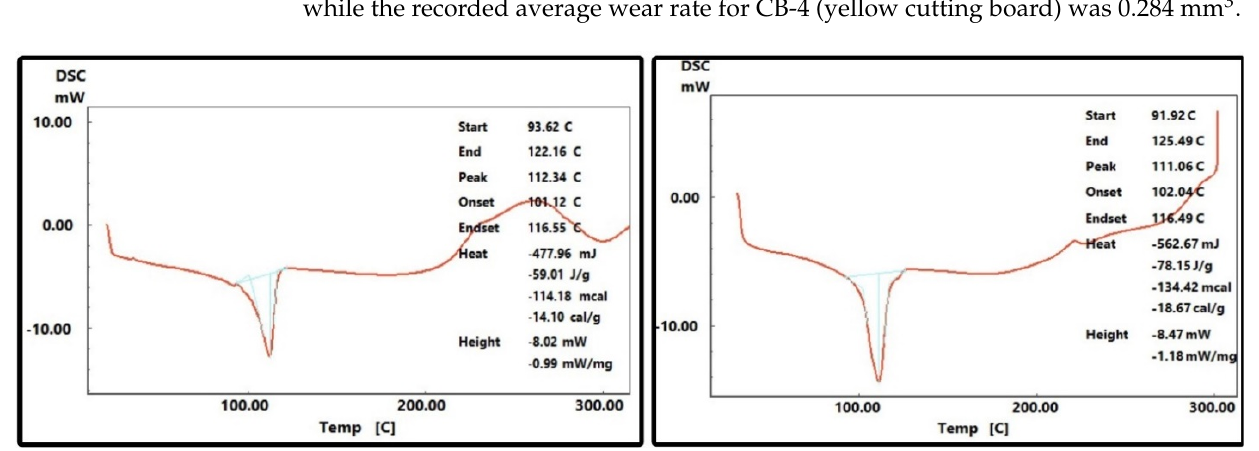
Figure 4. Differential scanning calorimetry (DSC) curves of polythene material from CB-3 ( right ) and CB-4 ( left ).